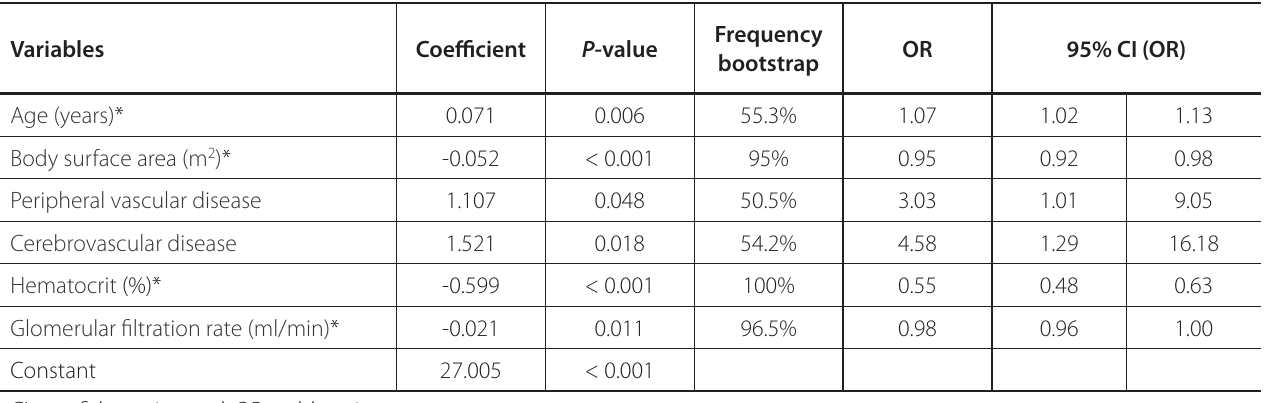
Table 4 . Risk-prediction